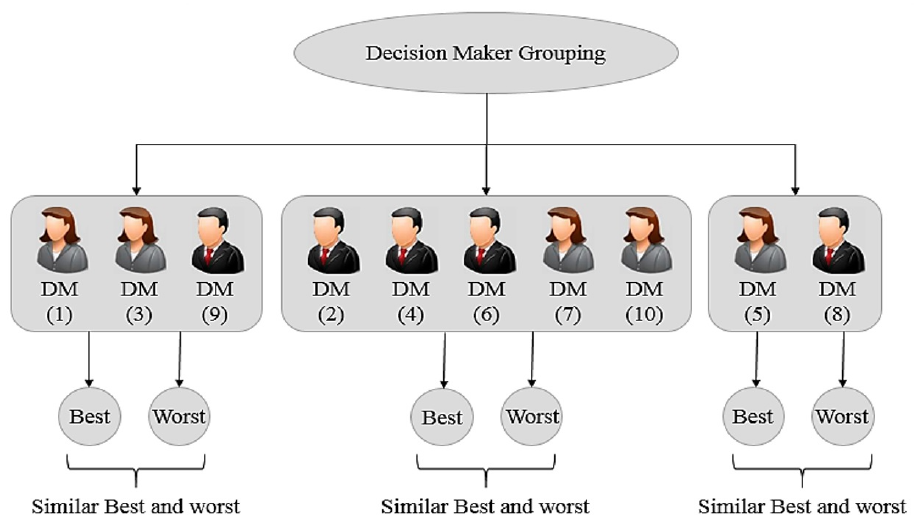
Figure 2. Best and worst criteria in each